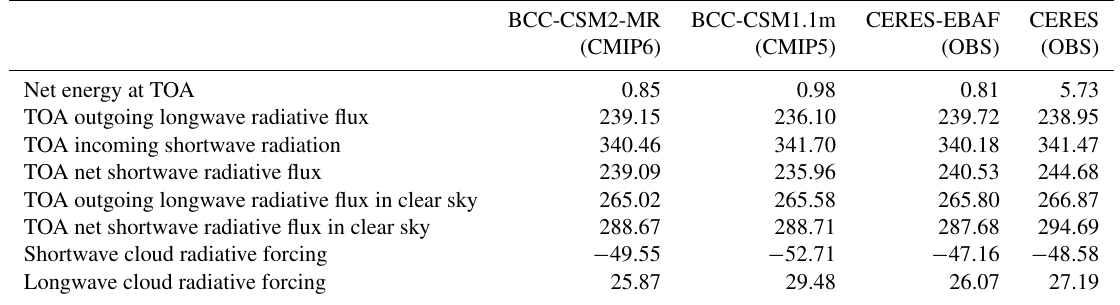
Table 4. Energy balance and cloud radiative forcing at the top-of-atmosphere (TOA) in the model with contrast to CERES-EBAF and CERES observations. (Units: Wm − 2